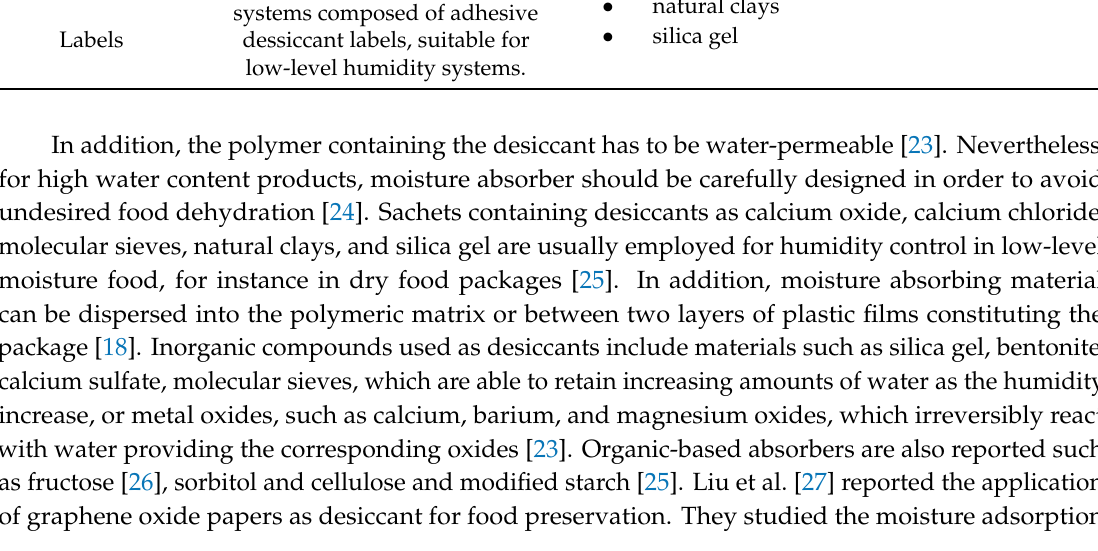
Table 2. The structure comprehends two layers of microporous non-woven plastic film in polyethylene, polypropylene, etc. containing the active substance, such as superabsorbent polymer, silica gel-based adsorbents, sodium chloride, starch copolymers, etc. [21,22]. For package design, it is important that